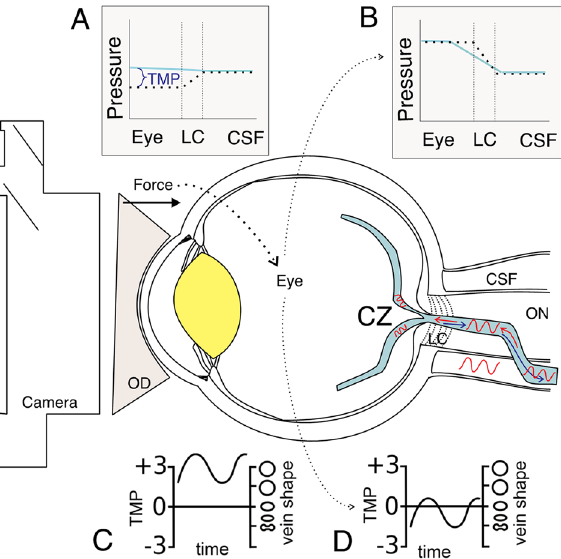
Figure 6. Schematic diagram of experimental setup. Cerebrospinal fluid pressure (CSF) pulse generates central retinal vein pulsation, which propagates retrograde (red) to flow (blue) towards the central zone (CZ) on the optic disk surface, then into upper and lower hemiveins on the disk and retinal surface. When CSF pressure is elevated above eye pressure (IOP—eye) the venous pressure (blue line, A ) will be greater than surrounding tissue pressure (dashed line A ) in the eye and lamina cribrosa (LC). This leads to a high transmural pressure (TMP in C ) which results in minimal vein shape change over the pulse pressure range due to the venous compliance characteristics ( C ). If an ophthalmodynamometer is applied (OD) with some force, eye pressure can be elevated to balance or exceed CSF pressure. In ( B ) it exceeds CSF pressure with a pressure drop across the LC resulting in a lower TMP favouring significant and visible venous shape change (pulsation) across the pulse pressure range ( D ). A video camera can record the venous